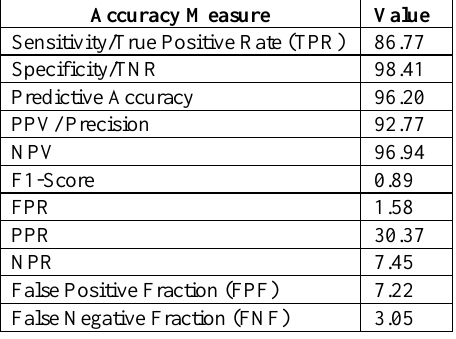
Table 1: Accuracy